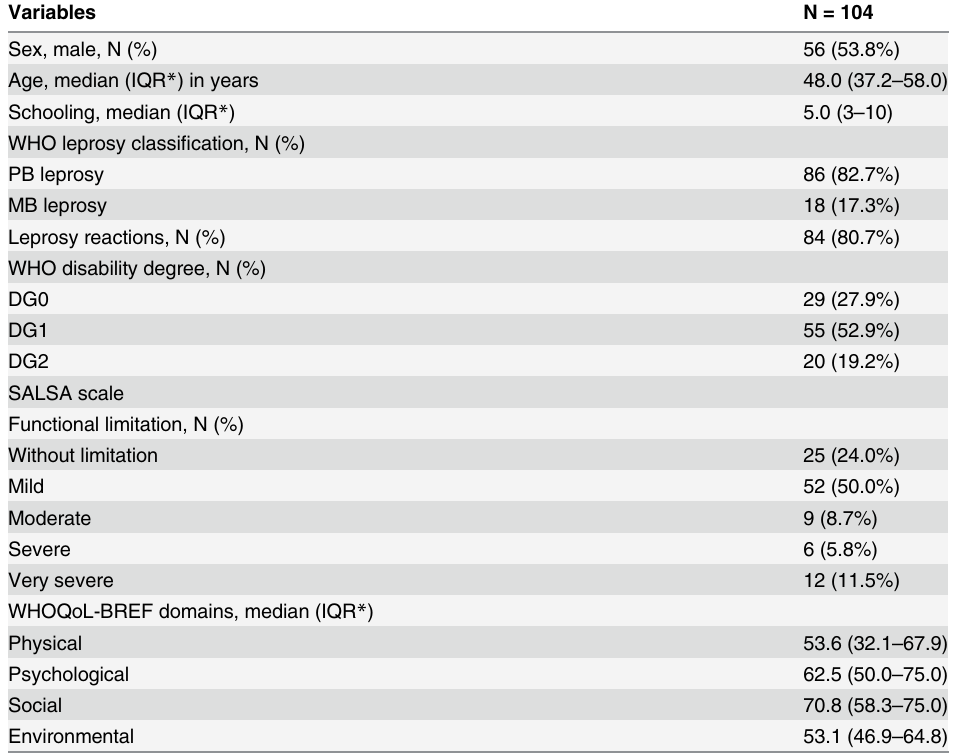
Table 1. Demographic characteristics of study